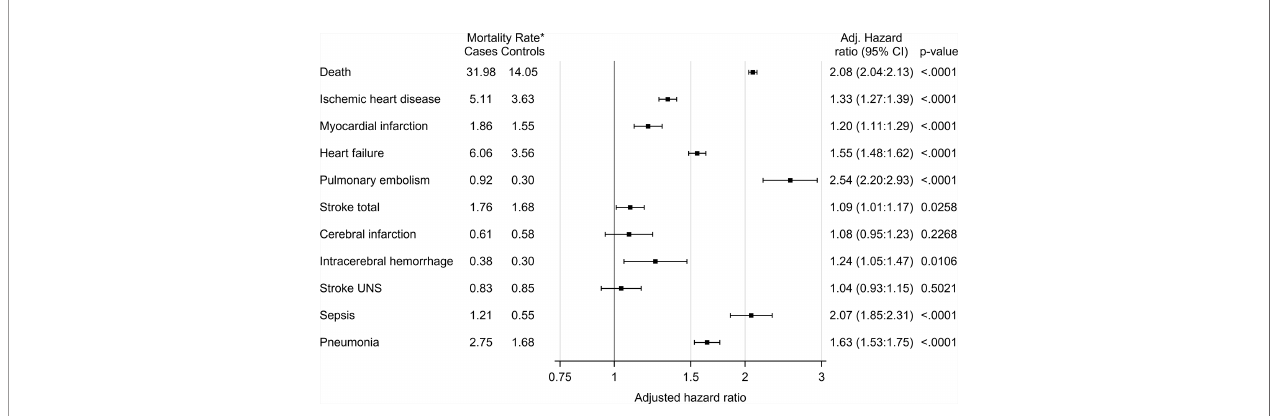
*Thecauseofdeathcanbeboththeprimarycauseofdeathandcontributingcausesofdeath,sothetotalnumberofdeathsisthereforehigherthanthetotaldeathsduetodisease-speci fi cdeaths. **Hazard ratio adjusted for comorbidities (diabetes ICD-10 code E10-E14, deep vein thrombosis I80-I82, pulmonary embolism I26, hypertension (more than 2 dispensed prescription of antihypertensive drug), stroke I64, ischemic heart disease I20-I25, heart failure I50, pneumonia J12-J18, malignant neoplasm C00-C97). † Cerebral infarction, intracerebral hemorrhage, and stroke not speci fi ed as hemorrhage or infarction. CI, con fi dence interval; GC, glucocorticoid; UNS, unspeci fi ed; ICD, International Classi fi cation of Disease.